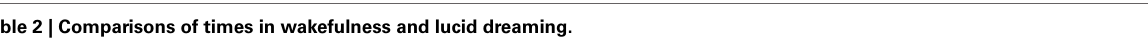
Table 2 | Comparisons of times in wakefulness and lucid